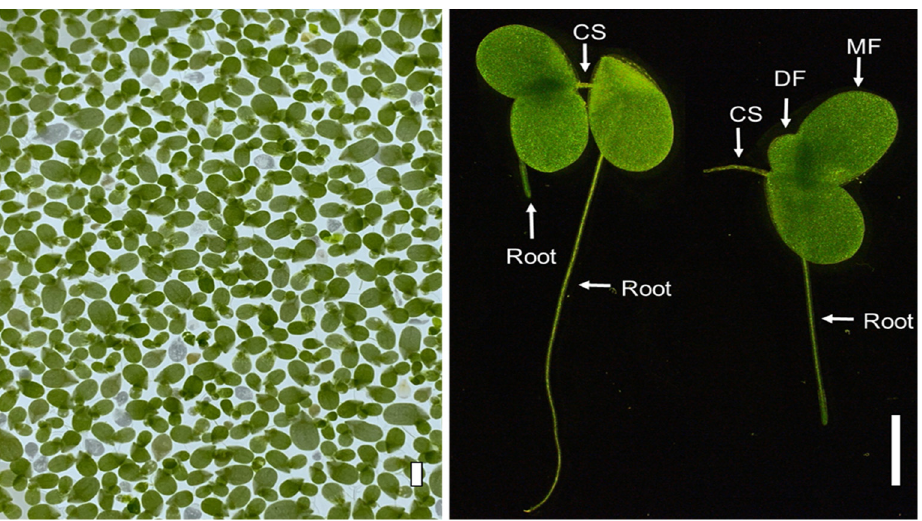
Figure 1. The common duckweed Lemna minor 5631. Numerous fronds are shown (left), and representative plants are shown in side view (right). CS, Connective stalk; DF, daughter frond; MF, representative plants are shown in side view ( right ). CS, Connective stalk; DF, daughter frond; MF, mother frond. Scale bar = 2 mm. mother frond. Scale bar = 2